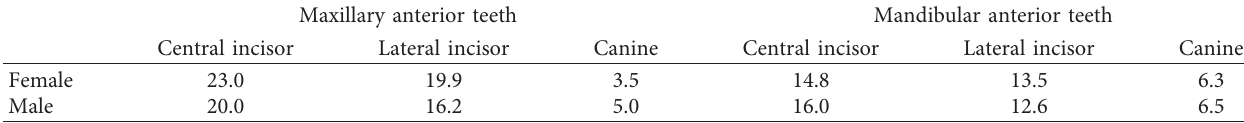
Table 4: Percentage of TDR in relation to its CCL for male and female participants.